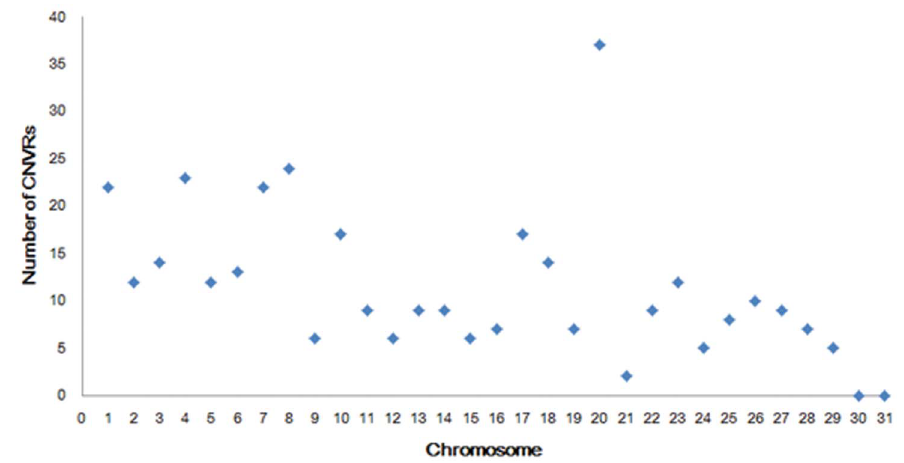
Figure 3. Chromosome distribution of the number of CNVRs.